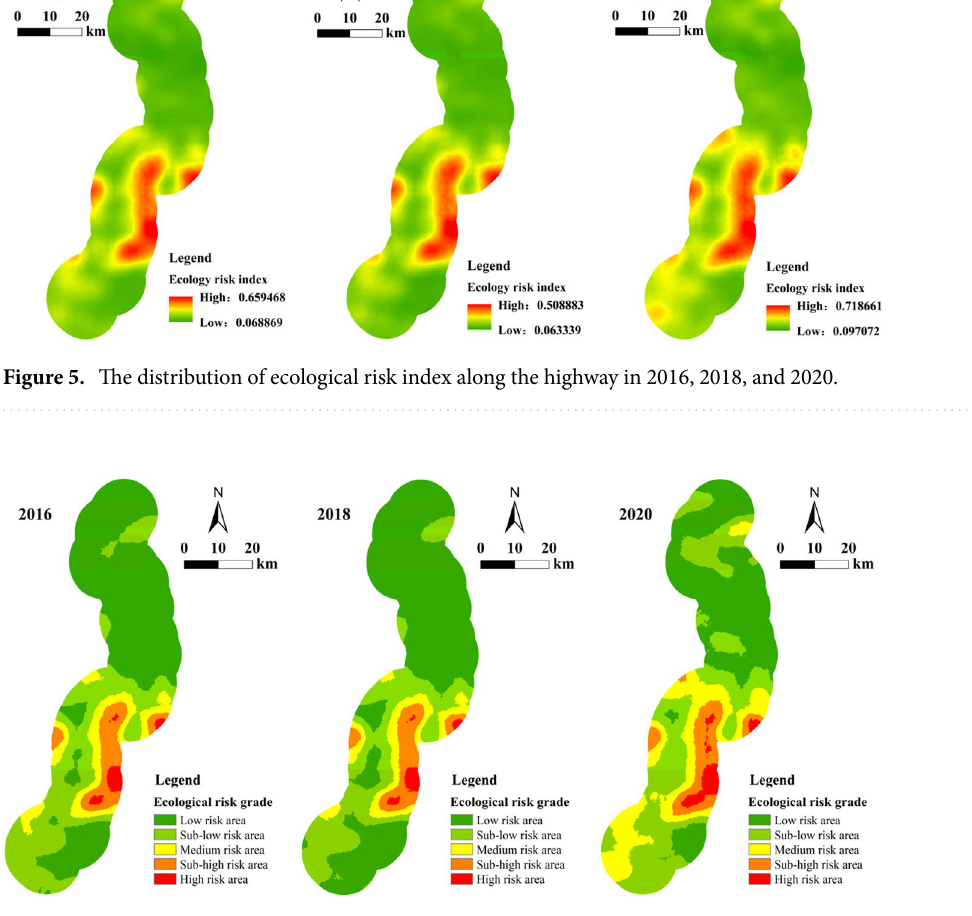
Figure 6. Distribution of ecological risk levels in 2016, 2018, and 2020.